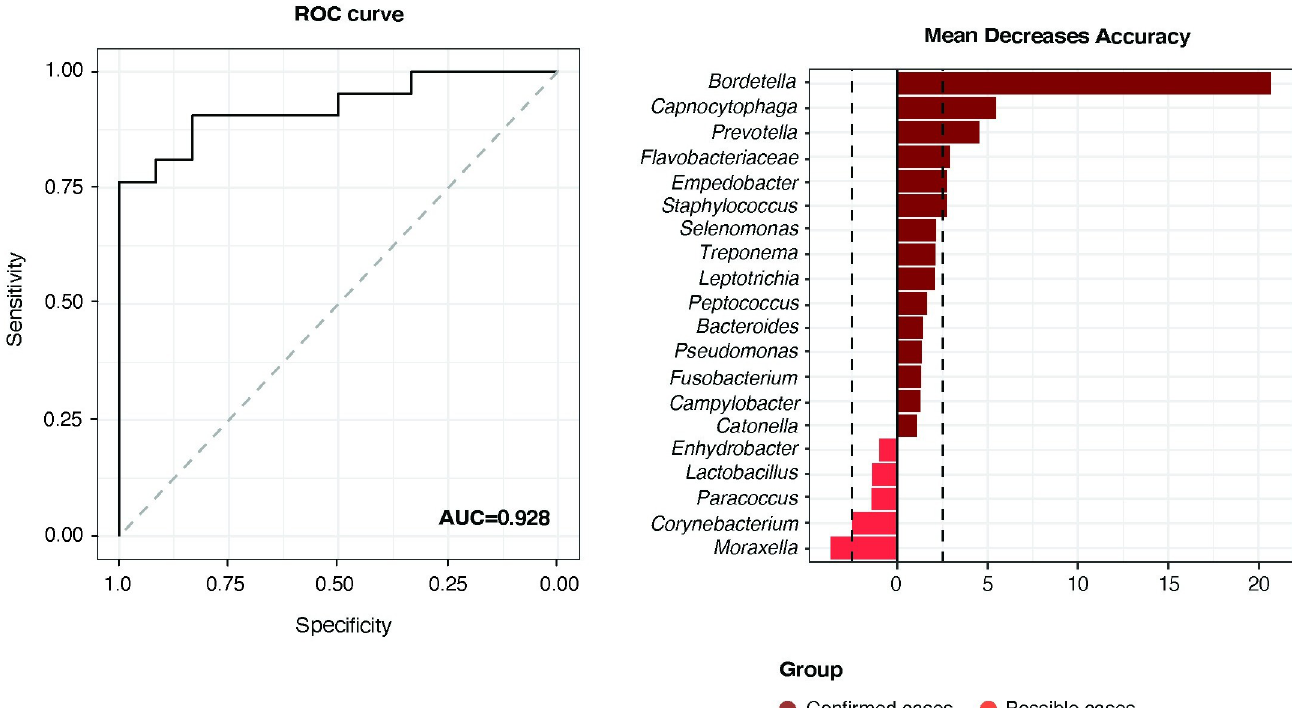
Fig 4. Bordetella genus is the best, although not unique, bacterial target for whooping cough diagnosis. A) The random forest model resulting AUC-ROC curve showing its performance to discern between confirmed and possible cases of whooping-cough based on the nasopharyngeal microbiota composition . B) Barplot showing the single variable analysis of the random forest model. The length of bars along the x-axis represents the Mean Decrease Accuracy (MDA) value for each bacterial taxon as a metric for its importance in the model. The MDA significance threshold is set to 1 and variables with an absolute MDA score > 2.5 are highlighted. Bacterial taxa are ordered from more to less discriminative and split by the group they correlate to (red for possible cases, magenta por confirmed cases).